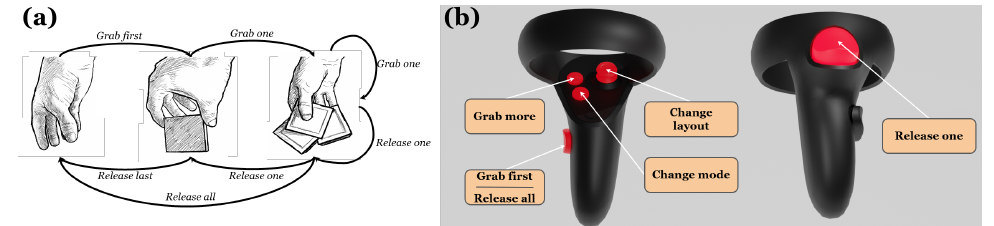
Figure 1. Multi-object grasp technique: ( a ) state transition diagram; ( b ) actions mapped into the controller’s